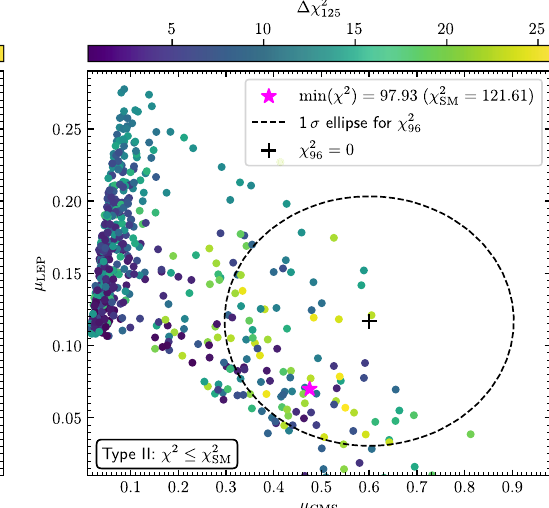
highlighted with a magenta star. The colors of the points indicate χ 2 in the right the left plot and (cid:14)χ 2 125